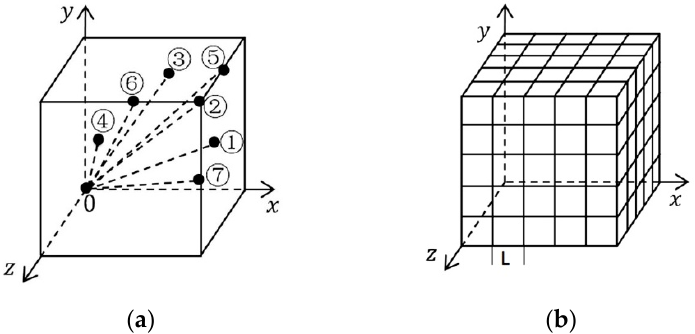
Figure 2 . Three-dimensional space. ( a ) Distribution types of straight lines in three-dimensional space. ( b ) Three-dimensional space